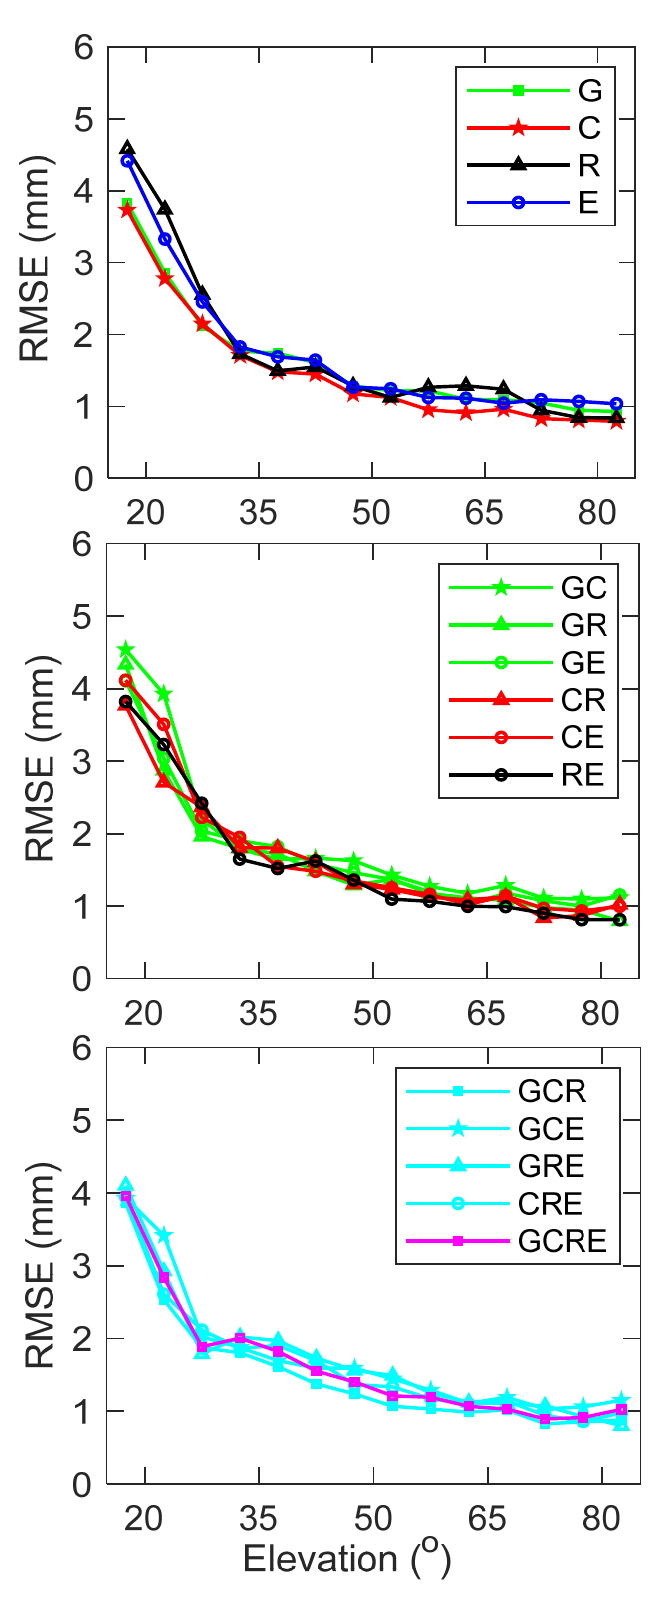
Figure 7. Comparison of SWV residuals in each elevation bin for various combinations. Radiosonde data are well suited as a reference to validate the accuracy of the water vapor tomography results, since they can provide a water vapor density profile with high precision based on the atmospheric parameters obtained at different altitudes. Figure 8